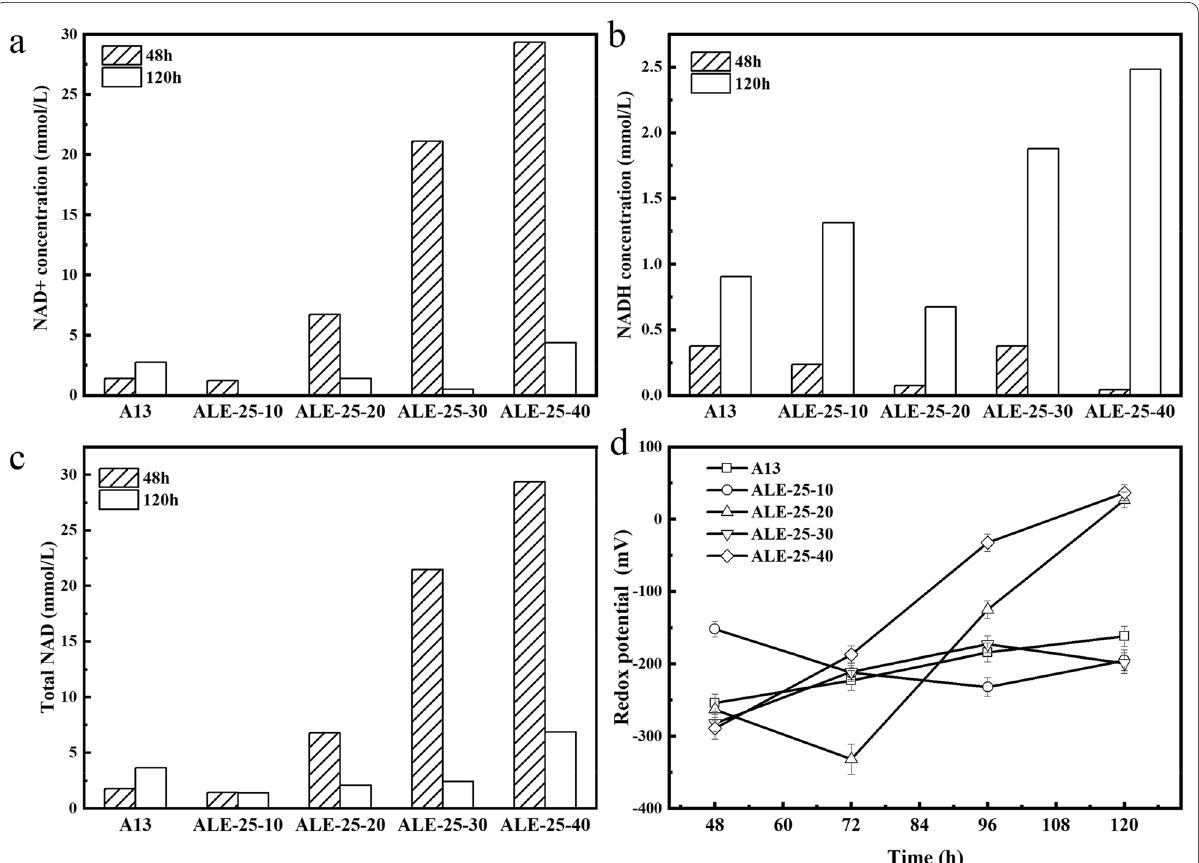
Fig. 3 Comparison of NADH ( a ), NAD + ( b ), total NAD ( c ) concentrations and redox potential ( d ) of different adaptive strains and original